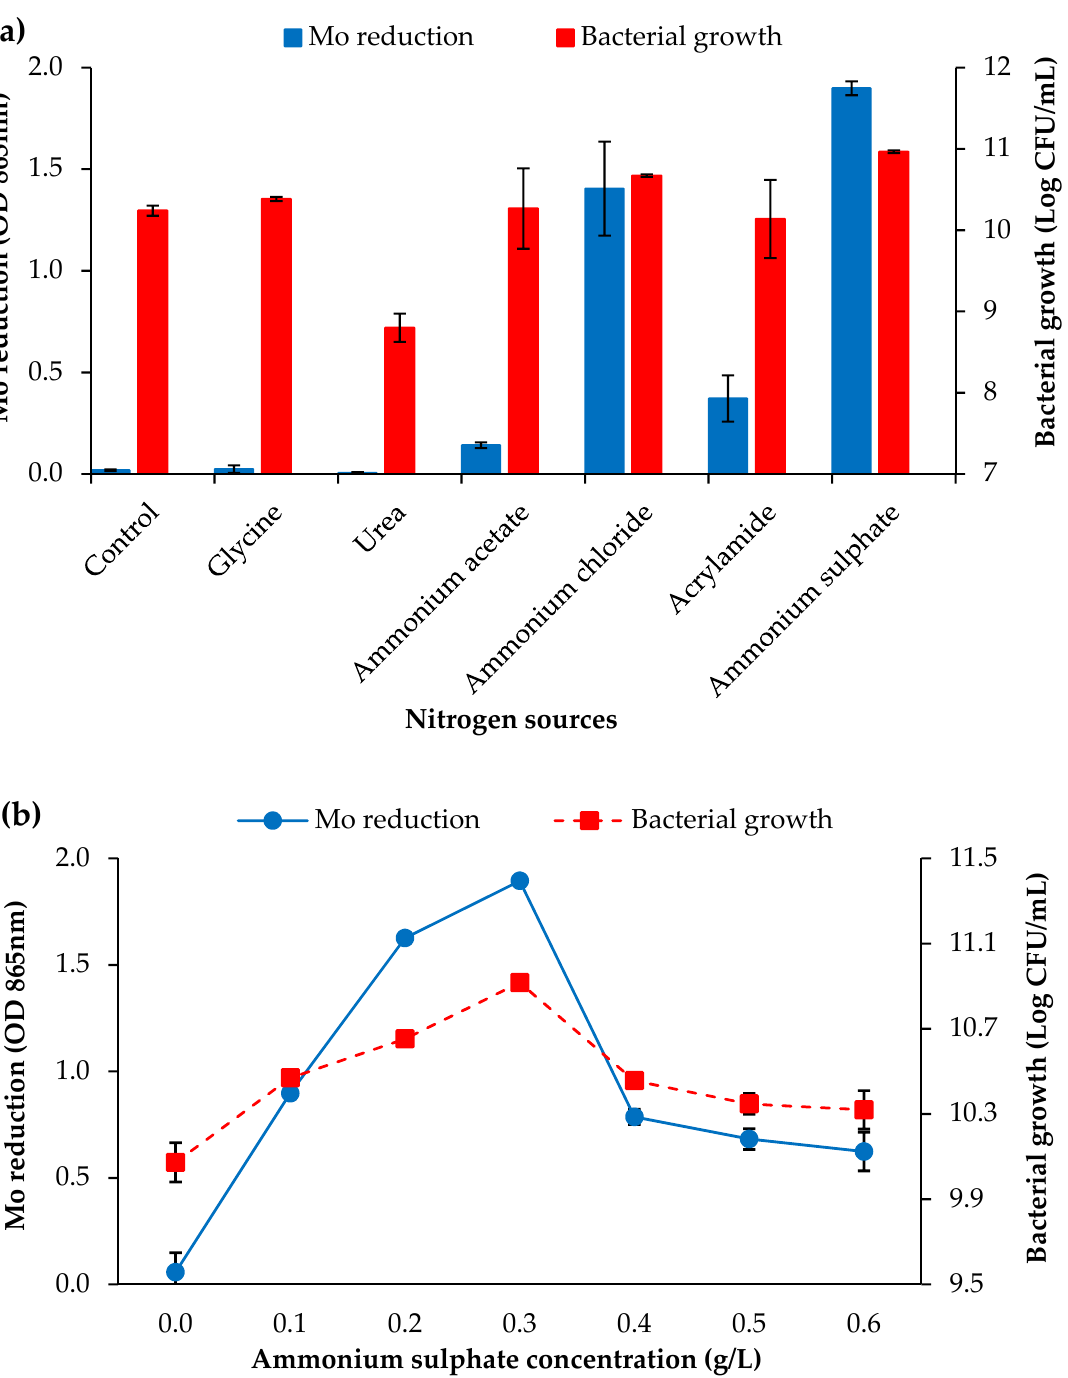
Figure 3. ( a ) The effects of different nitrogen sources at an initial concentration of 0.3 g/L; ( b ) the effect of different concentrations of (NH 4 ) 2 SO 4 on Mo reduction and growth of strain AQ5-05 in LPM. The error bars represent the mean ± standard deviation for three replicates.